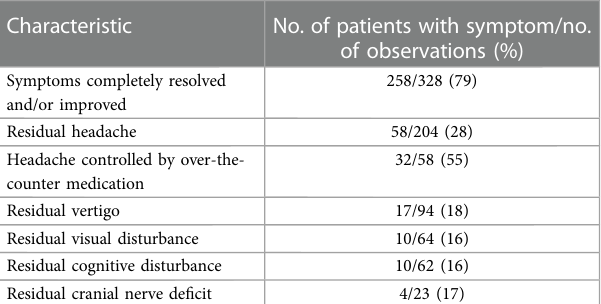
a Data are presented as number (%) of 454 observations unless otherwise noted. 32 (55%) reported an ability to control headache with over-the- counter pain medication. Of 23 patients assessed for cranial nerve recovery, 4 (17%) experienced residual cranial nerve de fi cits. Overall, 104 (23%) patients were asymptomatic and 350 (77%) were symptomatic at presentation ( Table 4 ). The proportion of patients with symptomatic presentation was greater among women (266/335 [79%]) than among men (84/119 [71%]). Compared with asymptomatic presentation, symptomatic